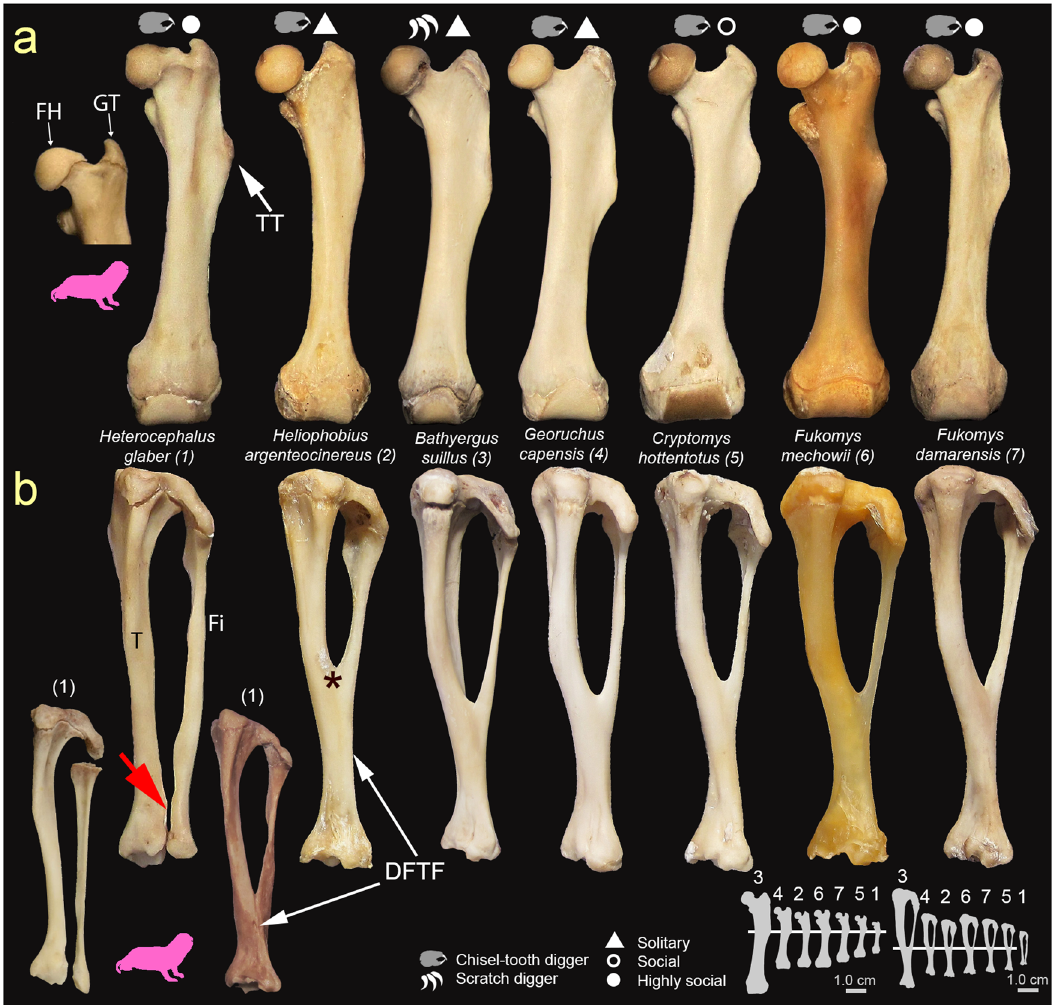
Fig. 3 Hind limb phenotype (femur and tibia- fi bula) of African mole-rats. a Anterior view of the femur showing the well-developed third trochanter (TT) in both scratch-digging and chisel-tooth digging genera. Note the variable condition (separated and fused) of the femoral head (FH) and greater trochanter (GT) in Heterocephalus glaber (pink silhouette). b Anterior view of the tibia (T) and fi bula (Fi) showing distal fusion (DFTFi) and junction point (*) in most species, as well as the non-ossi fi ed condition of H. glaber (red arrow). Two additional specimens of H. glaber (pink silhouette) are included to show the complete proximal and distal separation of T and Fi (left) and the exceptional fusion of such bones (right) (bones not to scale). Bone silhouettes show the real size of each bone among species, and correspond to the largest specimens of each species analyzed